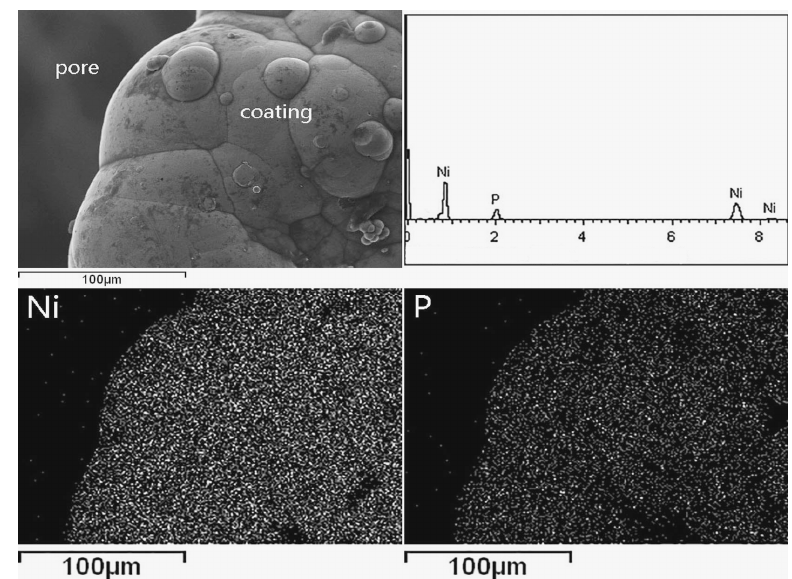
Figure 5. The element distribution of EN coating surface. Materials 2017 , 10 , 98